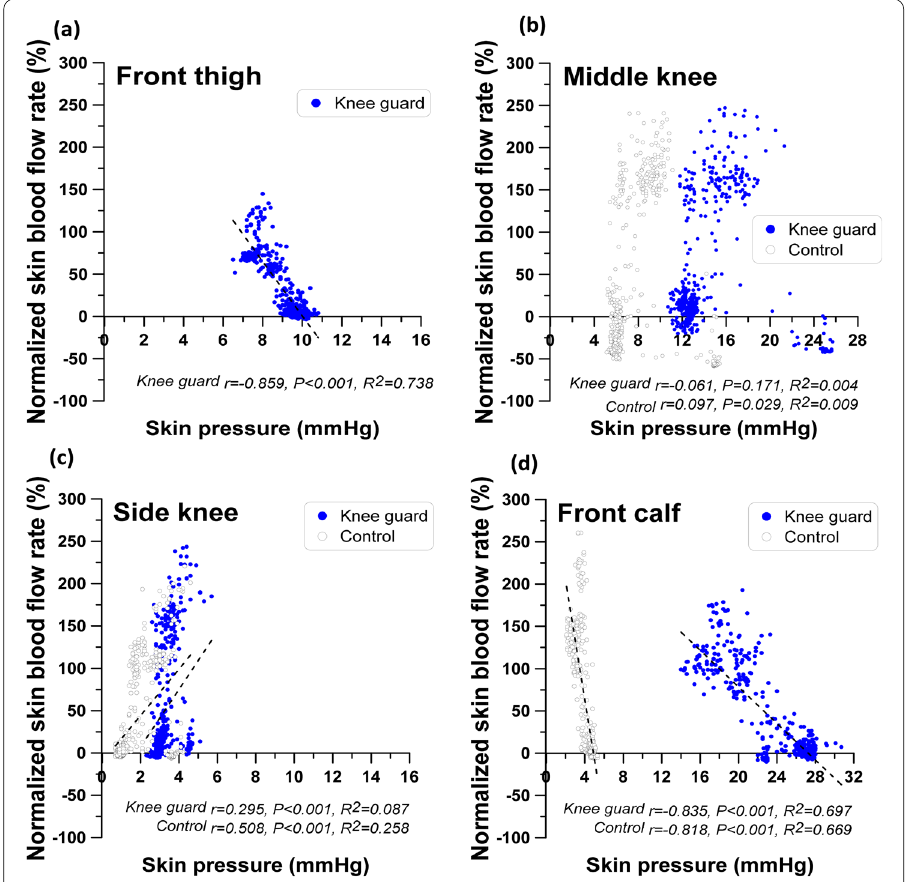
Fig. 5 Relationships between skin pressure and normalized skin blood flow for the control and knee guard condition (KG) on the front thigh ( a ), middle knee ( b ), side knee ( c ), and front calf ( d )